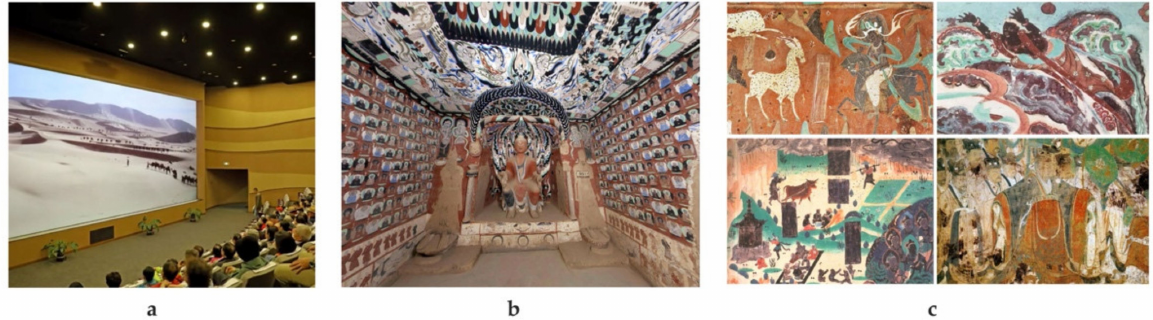
Figure 3. ( a ) Mogao Caves history film is shown in the Digital Exhibition Center. ( b ) Interior of Mogao Caves. ( c ) Frescos of Mogao Caves.